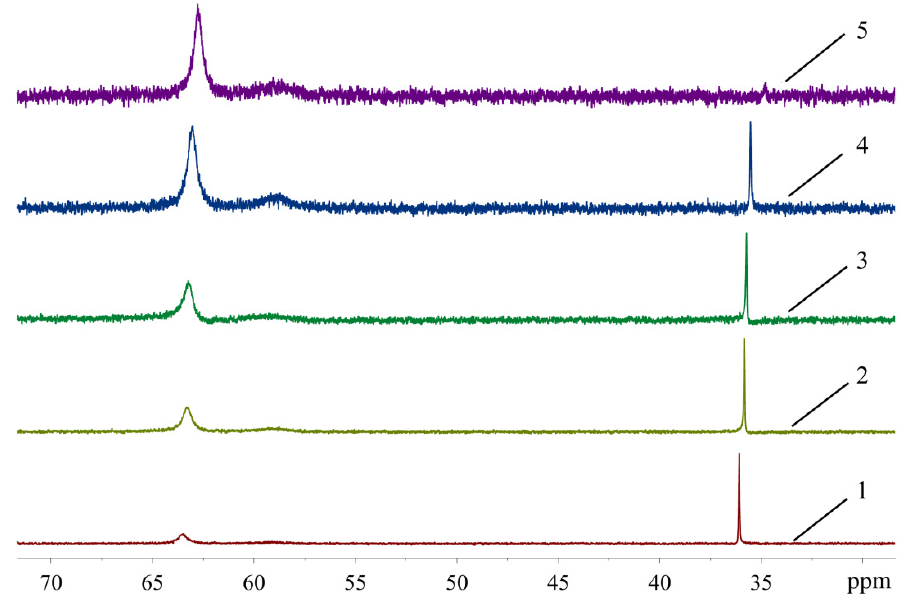
6 (region of H atoms of aromatic systems).